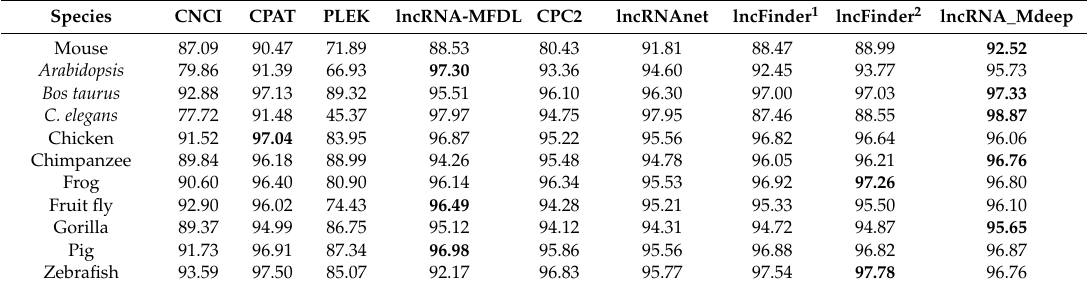
Table 3. Accuracy (%) of lncRNA_Mdeep and other eight methods on 11 cross-species datasets. Species CNCI